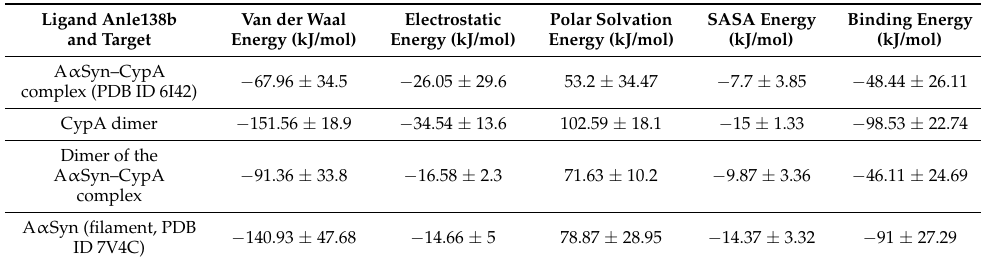
Table 4. Free interaction energies for studied ligand–target variant complexes (MM-PBSA analysis). Ligand Anle138b and